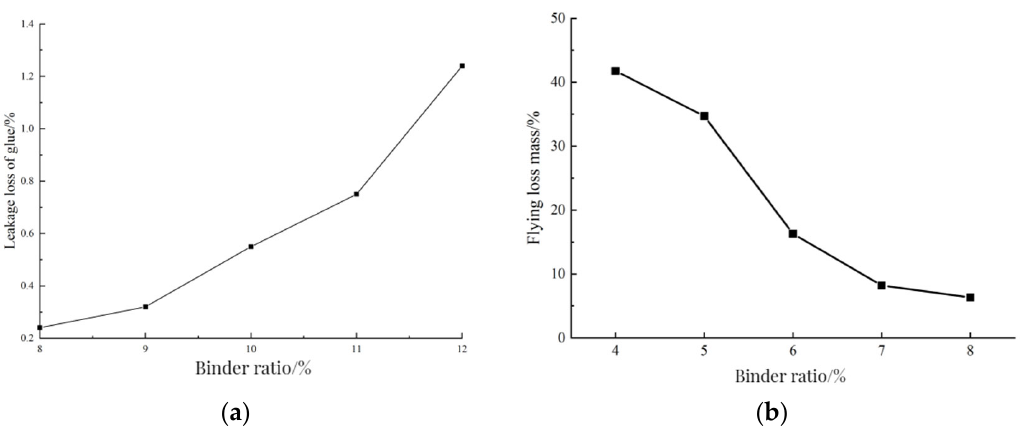
Figure 5. Sca tt ering and leakage test results. ( a ) In fl uence of cement–stone ratio leakage loss. ( b ) Figure 5. Scattering and leakage test results. ( a ) Influence of cement–stone ratio leakage loss. Results of sca tt ering experiment. ( b ) Results of scattering